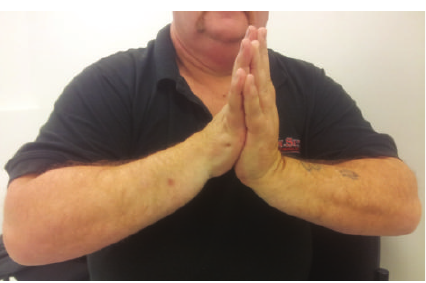
Figure 7: Postdistraction wrist